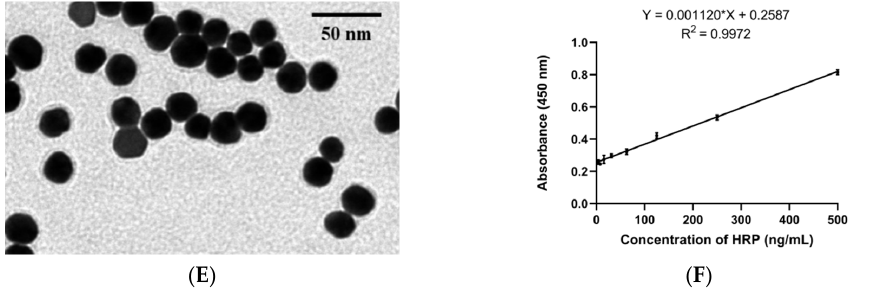
Figure 3. ( A ) Absorption spectrum, ( B ) zeta potential distribution map, ( C ) TEM images of AuNPs, and ( E ) AuNP probe. The 50 nm scale bar applies to all TEM images. ( D ) Statistical histograms of particle size distribution and particle size through the corresponding ( C ) TEM images to obtain the results as a rough approximation of the mean diameter ± the standard deviation. We measured 270 particles were measured for statistics. ( F ) Standard curves of HRP at concentrations of 500, 250, 125, 62.5, 31.25, 15.6, and 7.8 ng mL − 1 diluted in PBS buffer. The data represent the average ±SD from at least two independent assays.